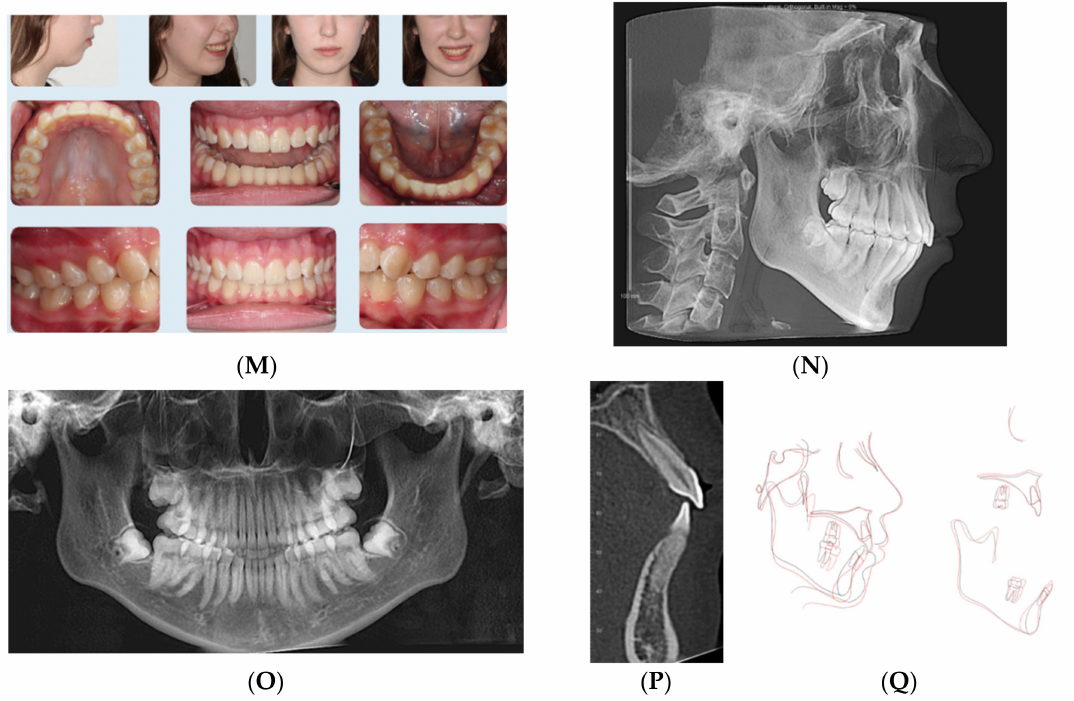
Figure 3. ( A ) Initial photographs showing convex profile with recessive chin and anterior crowding. ( B ) Initial digital models showing Class II Division 2 malocclusion with increased 5 mm overjet and impinging overbite. ( C ) CBCT-driven cephalometric radiograph showing convex profile with recessive chin and protrusive upper incisors. ( D ) CBCT panoramic radiograph showing the presence of permanent teeth; no other noticeable intraoral bony lesion could be detected. ( E ) CBCT-driven sagittal screen of lower incisor showing increased overjet and impinging overbite. ( F ) First digital treatment plan (ClinCheck) showing posterior teeth expansion and distalization. ( G ) Upper arch digital treatment plan (ClinCheck) showing expansion and distalization of posterior teeth (blue—initial teeth position, white—progress teeth position) and retraction of upper incisors to improve their initial protrusion. ( H )Lowerarchdigitaltreatmentplan(ClinCheck)showing(blue—initialteethposition, white—progress teeth position) lower arch expansion to allow lower incisor intrusion and leveling / alignment of lower incisor crowding. ( I , J ) Second digital treatment plan (ClinCheck) showing posterior teeth intrusion. ( K ) Upper arch digital treatment plan (ClinCheck) showing expansion of posterior teeth (blue—initial teeth position, white—progress teeth position) and retraction of upper incisors to improve their initial protrusion. (K) Lower arch digital treatment plan (ClinCheck) (blue—initial teeth position, white—progress teeth position) showing interproximal reduction between her lower teeth and lower incisor lingual movement to minimize anterior interference during forward rotation of the mandible as planned by the posterior teeth intrusion. ( M ) Final photos showing improved patient’s profile and chin projection as well as aligned upper and lower incisors and Class I buccal occlusion on both sides, improved overbite and overjet. ( N ) CBCT-driven final cephalometric radiograph showing improved profile and chin projection, although not ideal to straight profile, but patient and parents were satisfied with the results compared to initial clinical conditions. ( O ) Final CBCT-driven panoramic radiograph shows growing third molars to be followed for their eruption and possible removal if needed. ( P ) Final CBCT-driven sagittal screen radiograph of upper and lower incisors showing improved overjet and bone labial to both upper and lower incisors. ( Q ) Superimposition of cephalometric tracing of before (black) and after (red) treatment showing improved forward chin projection. However, challenges included vertical displacement of the mandible due to over-eruption of lower molars due to the patient’s mouth breathing habit and non-compliance of using the vertical-pull chin cup / Jaw Bra. Additionally, it shows lingual tipping of lower